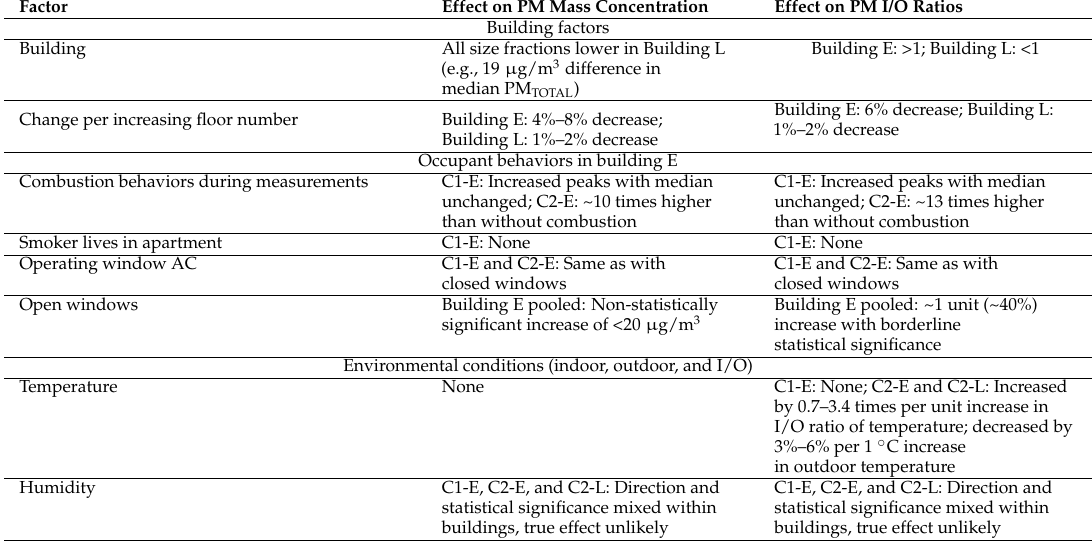
Table 3. Summary of the effects of building factors, occupant behaviors, and environmental conditions on PM mass concentration and I/O